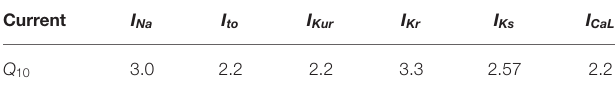
TABLE 2 | Temperature scaling factors ( Q 10 values) for different ionic currents.